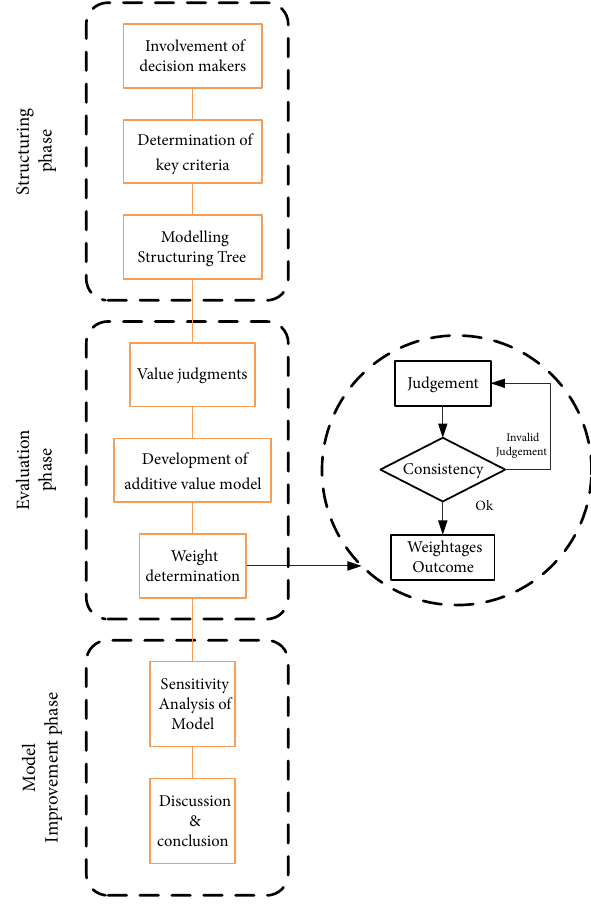
Figure 1. Typical classical MACBETH process in M-MACBETH